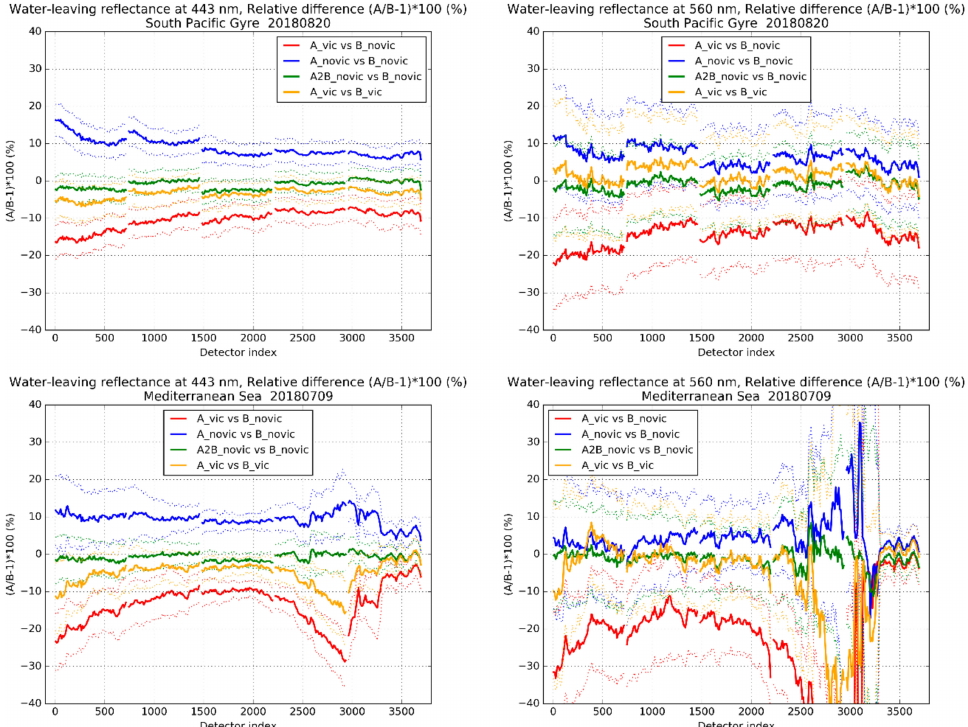
Figure 13 for ρ w at 443 nm and 560 nm (resp. Oa03 and Oa06) and Figure 14 for Chl show the relative di ff erences between OLCI-A and OLCI-B (taking this latter as the reference) for the di ff erent setups. Supplementary Figure S3 shows results for SPG for all bands from Oa01 (400 nm) to Oa06 (560 nm).